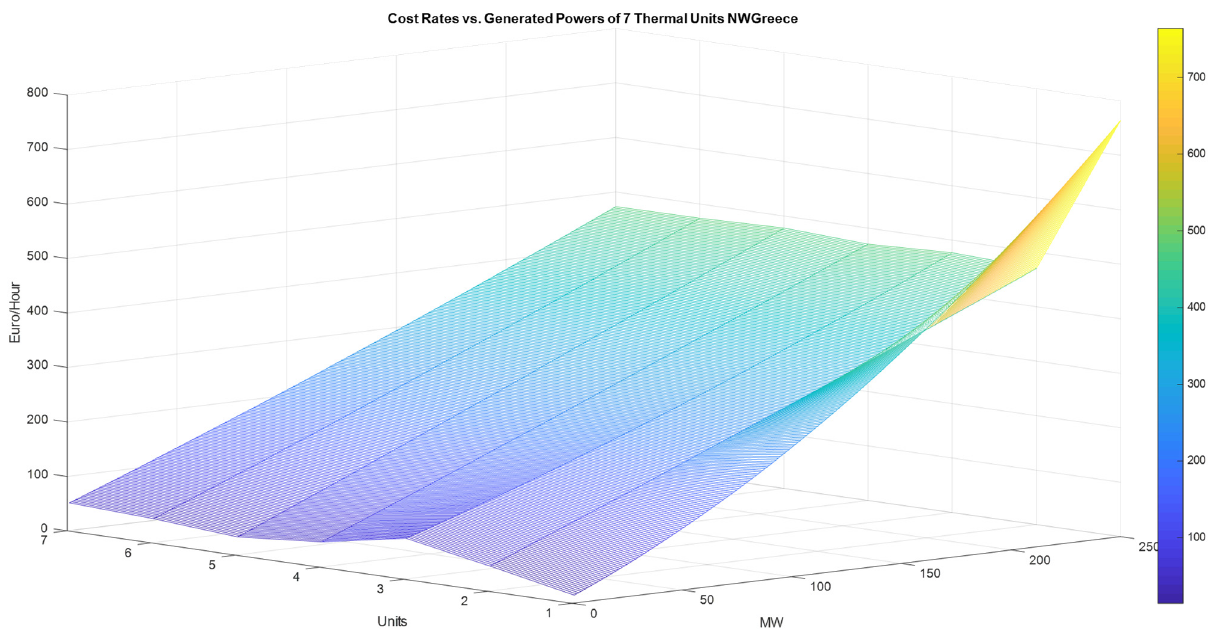
Figure 3. Cost rate functions versus generated power of seven thermal units from northwest Greece.